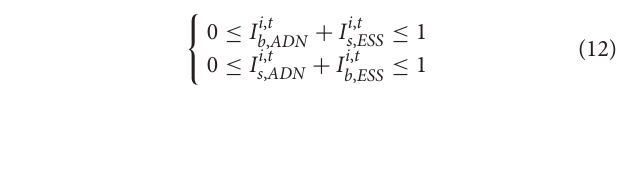
TABLE 3 | Operational parameters of the microgrid cluster